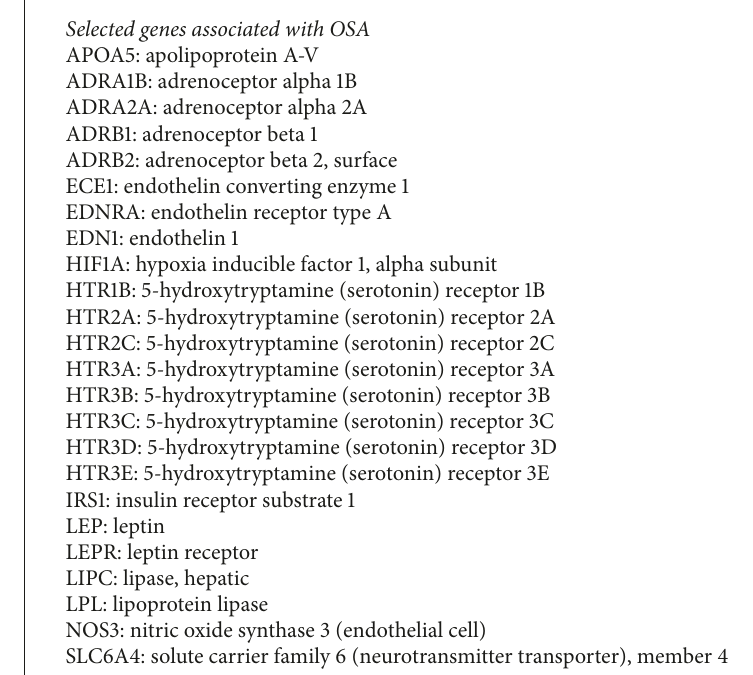
Box 1: Top 23 candidate genes identified by enrichment analysis. The box shows the 23 unique genes (in alphabetical order) identified from Enrichr analysis. The majority of the pathway genes are involved in serotonin based regulatory